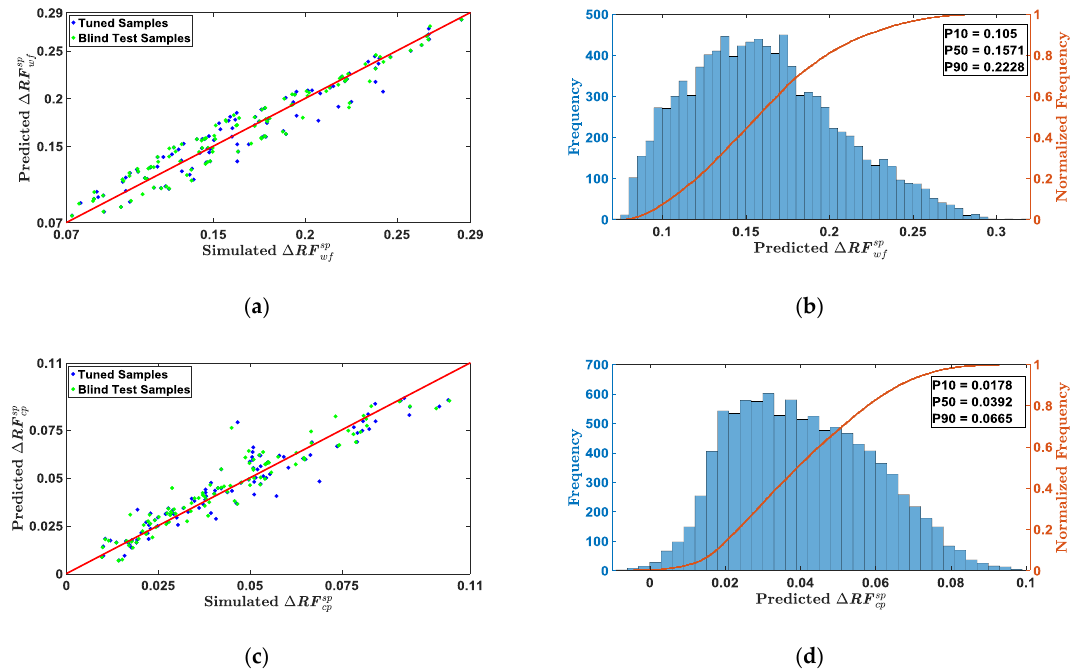
Figure 12. Assessment of proxy quality as part of the surrogate modeling workflow ( a , c ) and resulting probabilities from the Monte Carlo simulation ( b , d ) for the incremental oil recovery of the slug-based process over waterflooding ( a , b ), and over continuous polymer flooding ( c , d ).